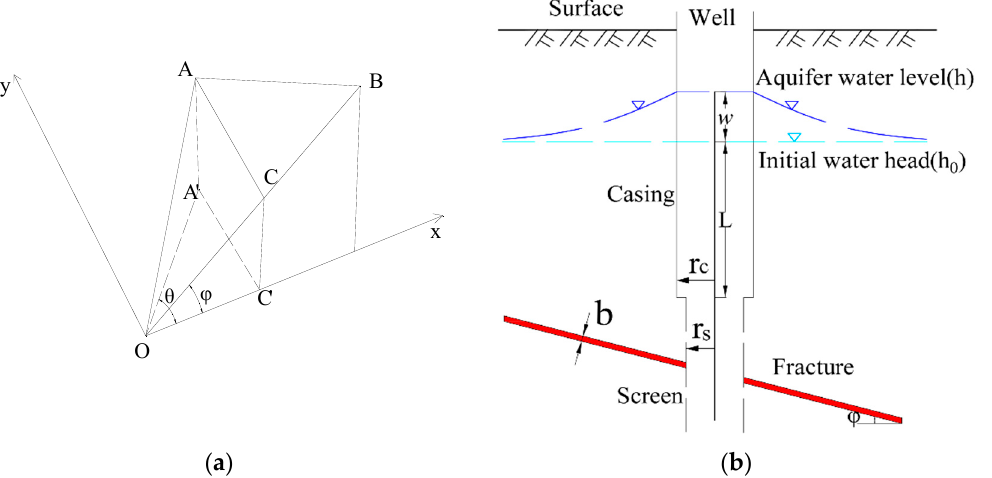
Figure 1. Slug test schematic on the dip fracture surface. ( a ) Coordinate system schematic on the dip fracture surface, ( b ) well structure